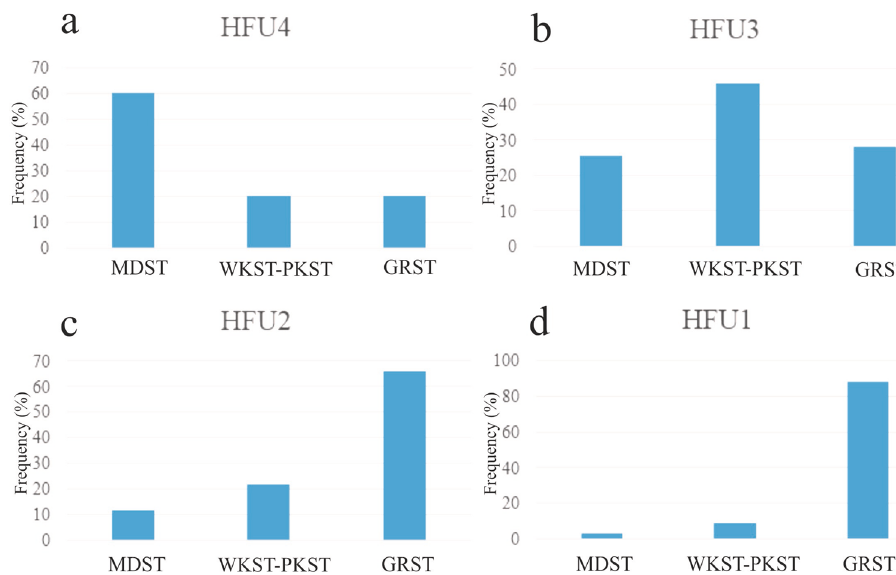
Fig. 9 The frequency of various facies in each HFU including MDST: mudstone facies (F1, F2), WKST-PKST: wackestone- packstone facies (F4, F5,and F6) and GRST: grainstone facies (F7,